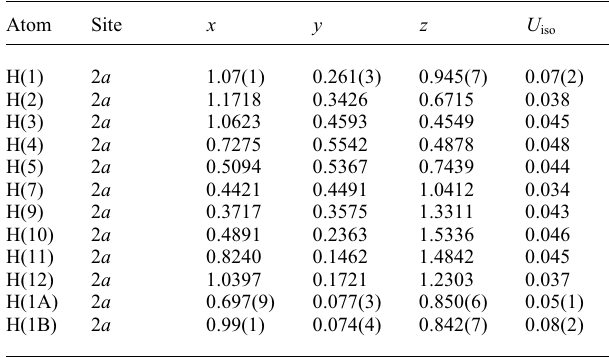
Table 2. Atomic coordinates and displacement parameters (in Å 2 )